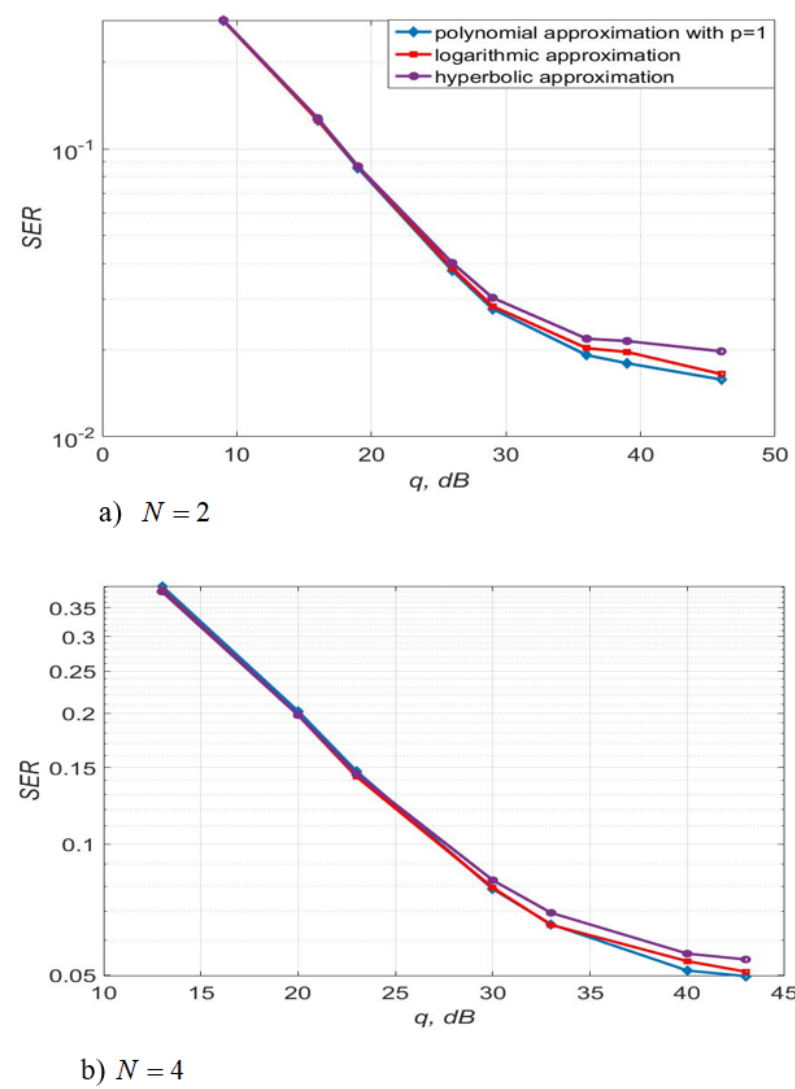
Figure 17. SER of 4-QAM versus SNR per bit for different approximating structures for MIMO sys- tems.